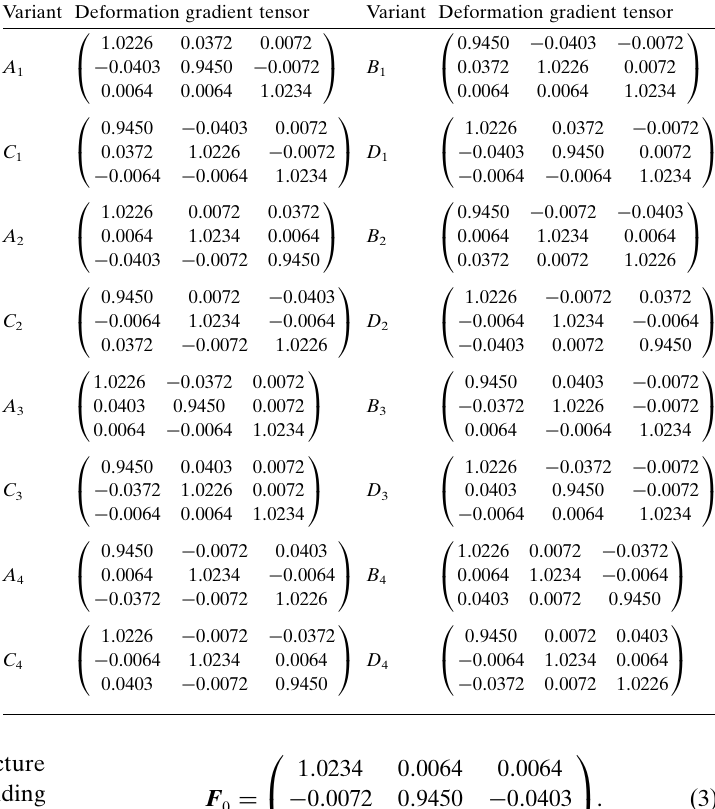
Table 5 Deformation gradient tensor F of variants in plates P 1 – P 4 in Fig. 1( b ) expressed in the Bravais lattice basis of austenite. Variant Deformation gradient tensor Variant Deformation gradient tensor